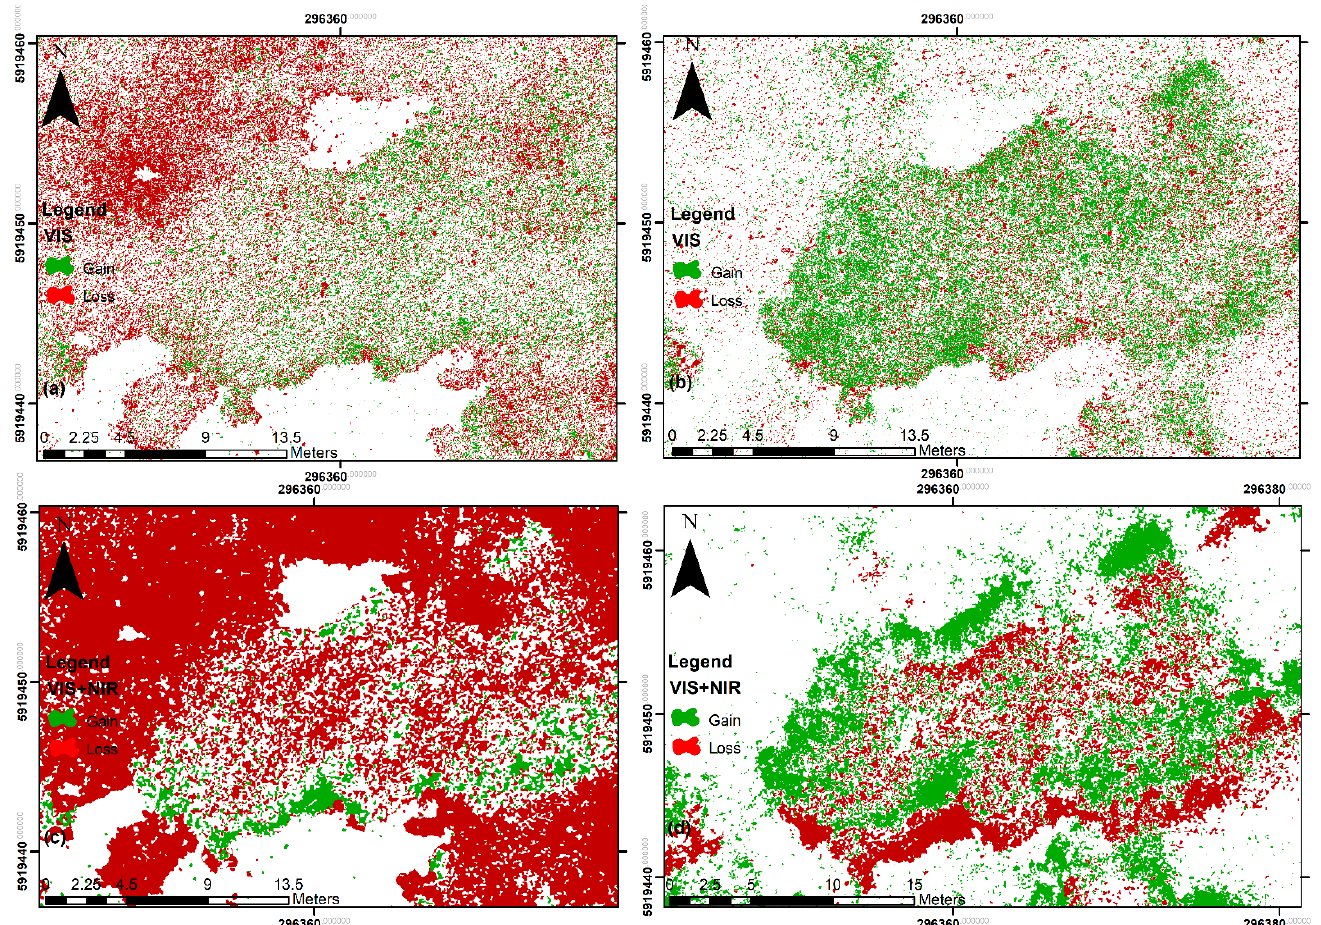
Figure 7. Time-series density seasonal change in seagrass meadows. Using VIS orthomosaic ( a ) gain and loss of seagrass across summer to autumn and ( b ) gain and loss across autumn to winter. Using VIS+NIR orthomosaic ( c ) gain and loss of seagrass from summer to autumn, ( d ) gain and loss across autumn to winter.